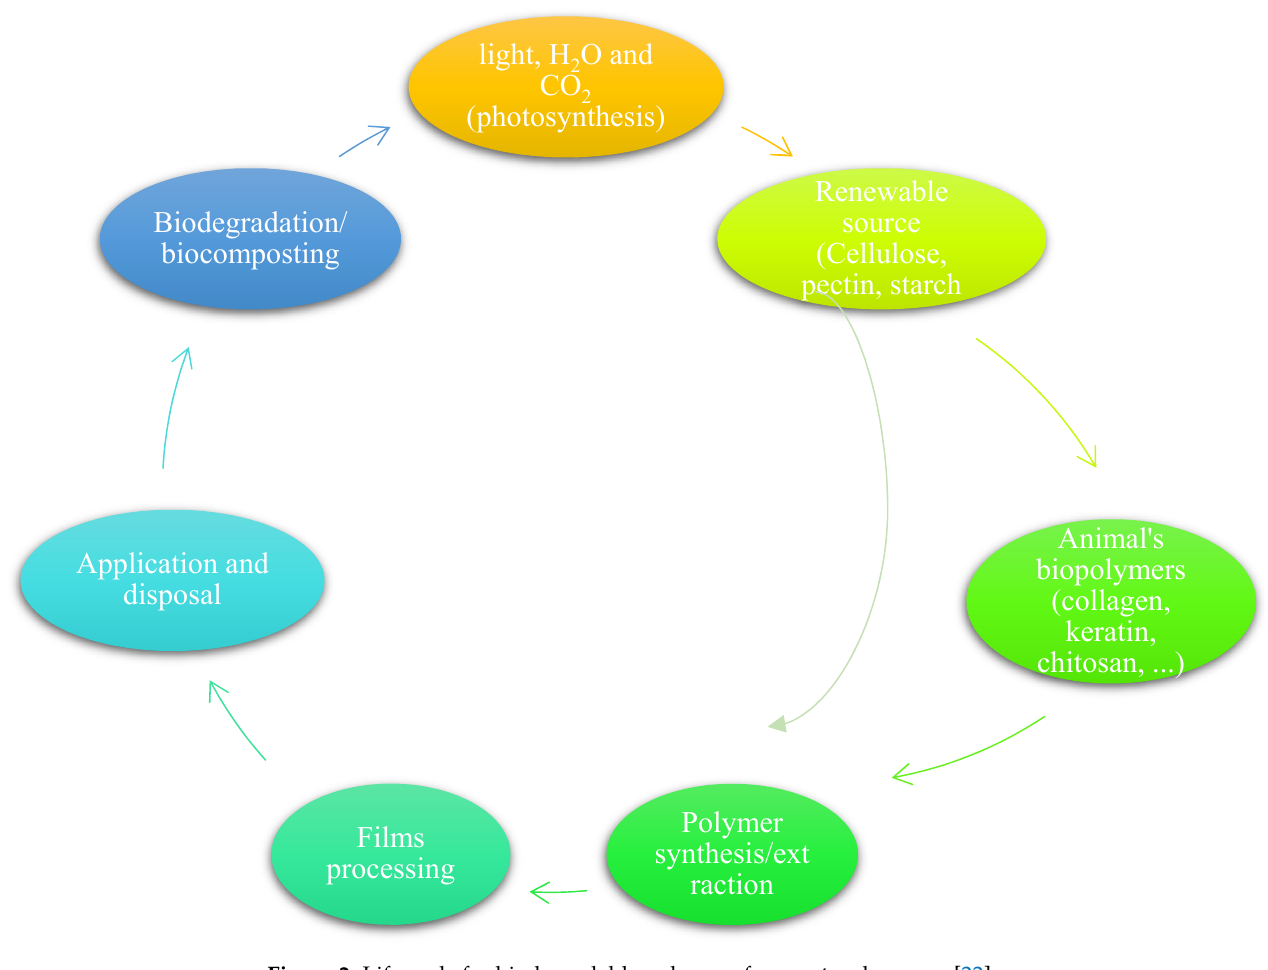
Figure 2. Life cycle for biodegradable polymers from natural sources [22]. Natural biopolymers, such as polysaccharides, proteins, and lipids, can be found abundantly from plant and animal sources and they have great potential to be used as feedstock for biodegradable packaging materials. Polysaccharides are the most abundant natural polymers in nature. Starch, cellulose, and its derivatives, pectin, chitosan,